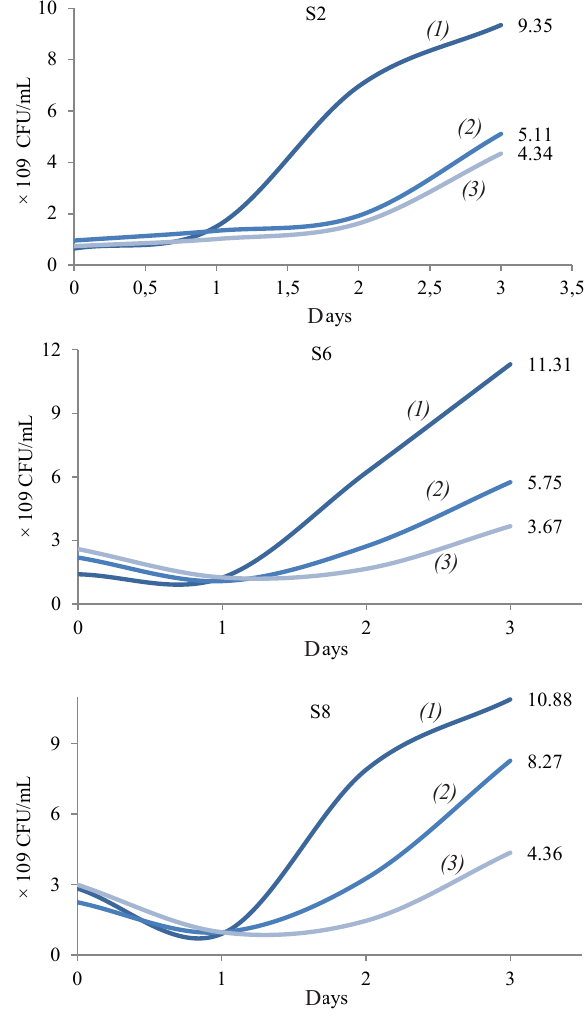
Figure 2 Total population of indigenous yeast: (1) – 27°C, (2) – 37°C, (3) –